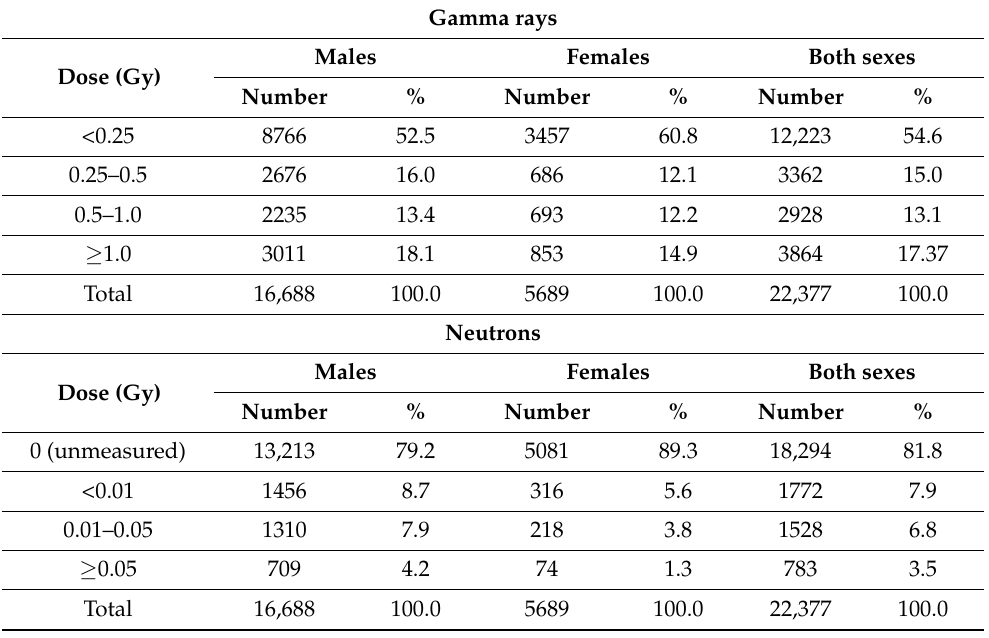
Table 2. Distribution of workers by brain absorbed dose from external